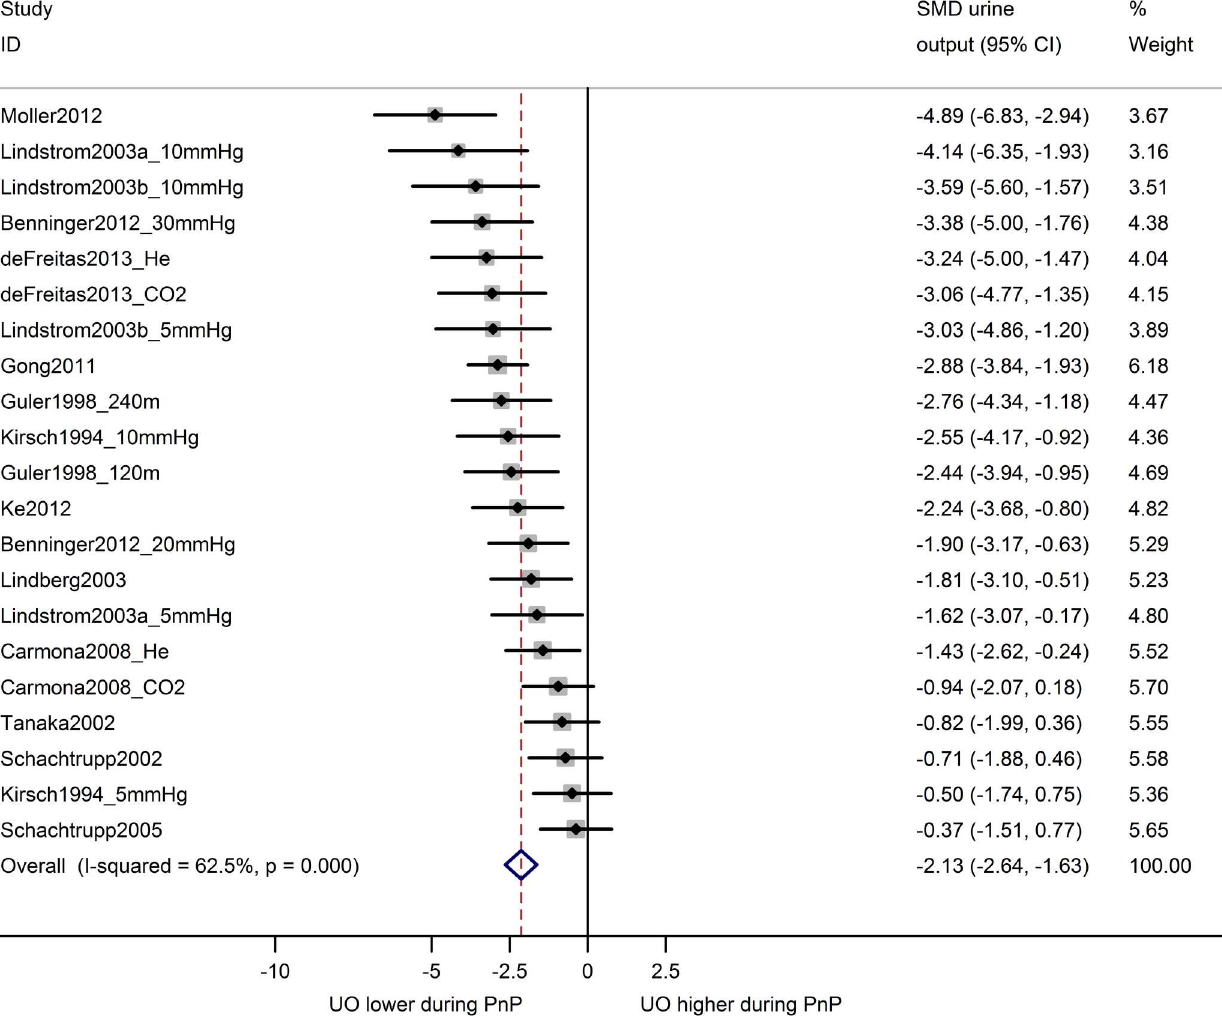
Fig 8. Urine output is decreased during pneumoperitoneum compared to controls. Forest plot of studies comparingurine output in animals undergoing pneumoperitoneum with control animals. Effect size is calculatedas standardized mean difference (SMD) in urine output, and corresponding 95% confidence intervals (95%CI). Weights are from random effects analysis. mmHg = pressure in experimental group; He = insufflation with helium; CO2 = insufflation with carbon dioxide; m = duration in minutes of PnP at time of